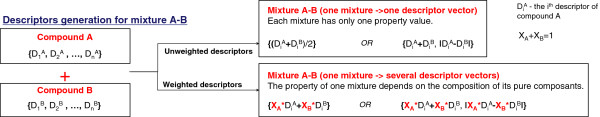
Methodology used to calculate descriptors for mixtures.